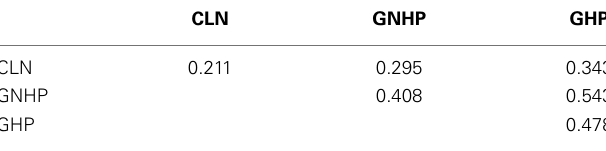
Table 1 |The average similarity between each pair of conditions